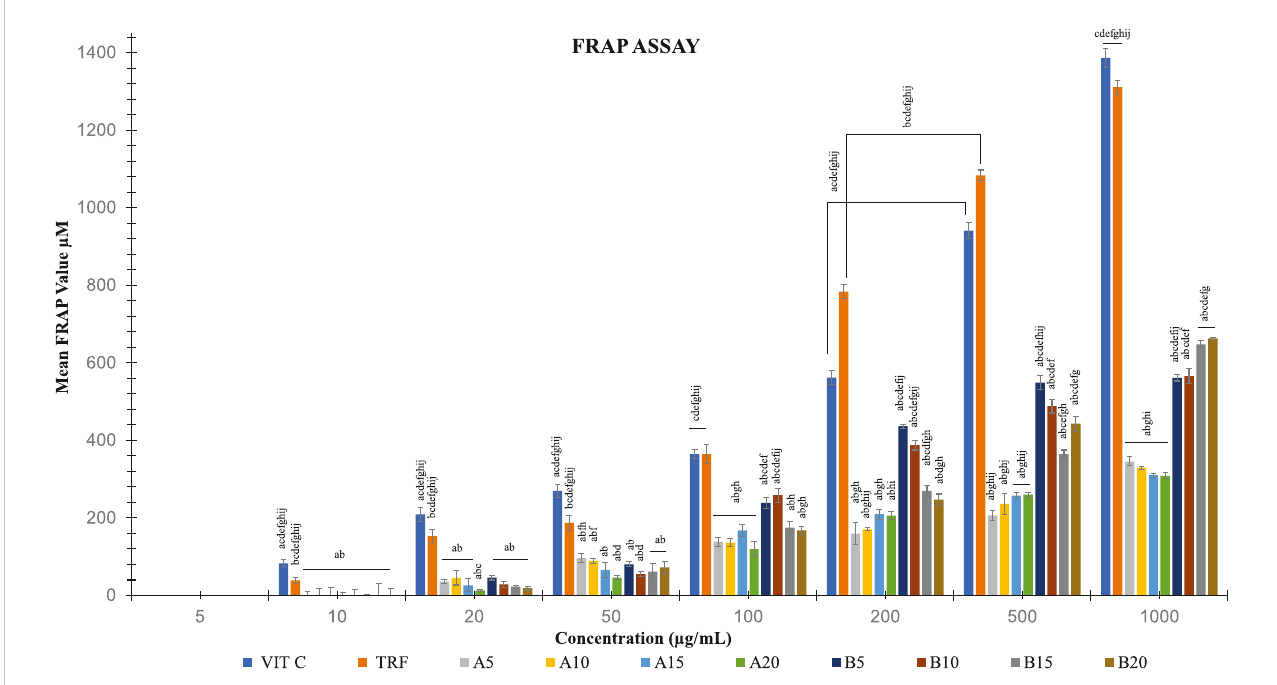
FIGURE 6 FRAPactivitiesinbothsoilandsoillessginger.ThedataisshownasmeanSD( n =6).A5,A10,A15andA20denotesoillessgingergroups.B5,B10,B15,B20 denote soil ginger groups. a p < 0.05 is signi fi cantly different from TRF, b p < 0.05 is signi fi cantly different from Vit C, c p < 0.05 is signi fi cantly different from A5, d p < 0.05 is signi fi cantly different from A10, e p < 0.05 is signi fi cantly different from A15, f p < 0.05 is signi fi cantly different from A20, and g p < 0.05 is signi fi cantly different from B5, h p < 0.05 is signi fi cantly different from B10, i p < 0.05 is signi fi cantly different from B15 and j p < 0.05 is signi fi cantly different from